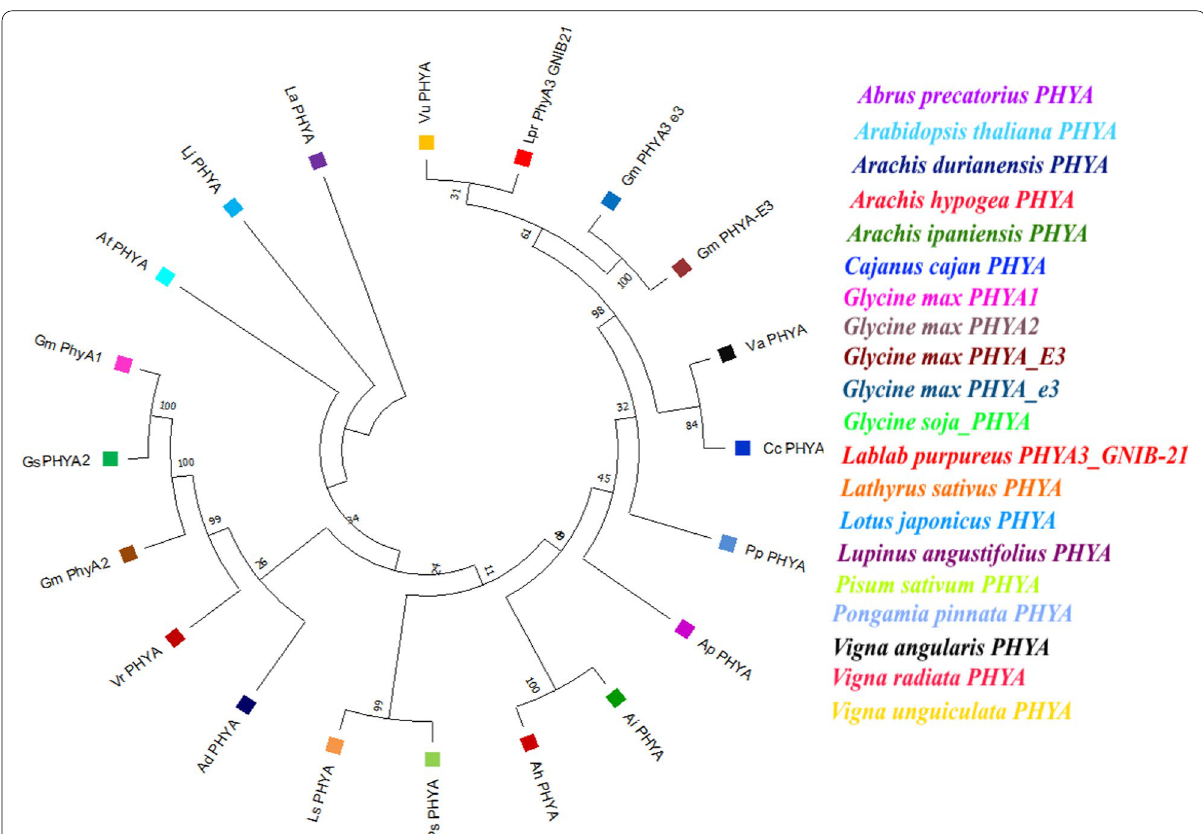
Fig. 1 Phylogenetic tree of the Phytochrome A gene inferred by the Maximum Likelihood algorithm corresponding to the lowest value of the Log Likelihood function. The percentages of bootstrap support (1000 replicates) are shown near corresponding nodes. Names of genes are included for each taxon. Arabidopsis thaliana , Lotus japonicus and Lupinus angustifolius are three